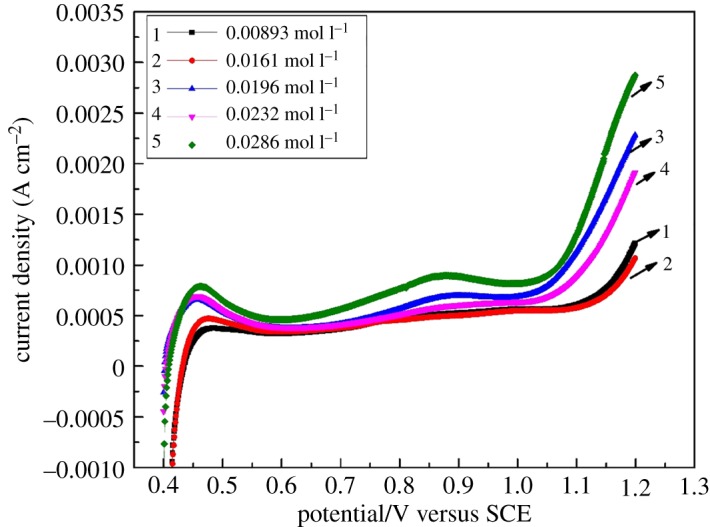
LSV curves of 2.8 M H2SO4 solution with different concentrations of Fe(III) at a scan rate of 0.001 V s−1.